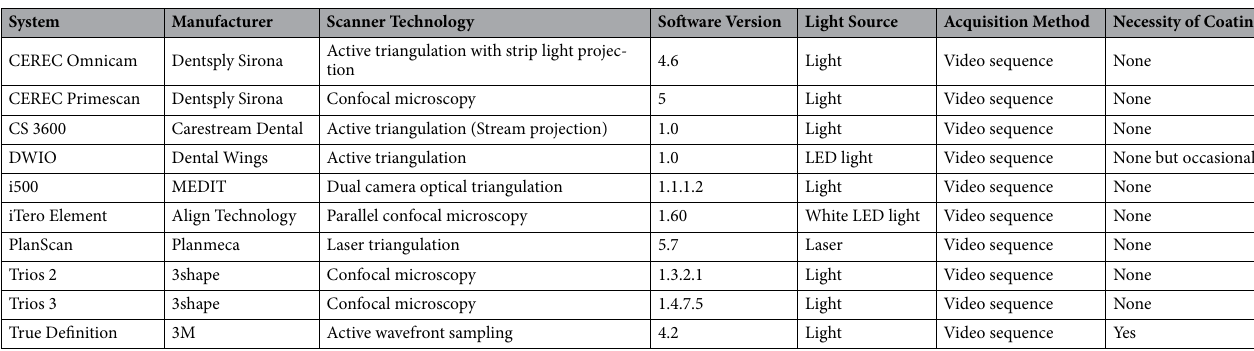
Table 1. Characteristics of intraoral